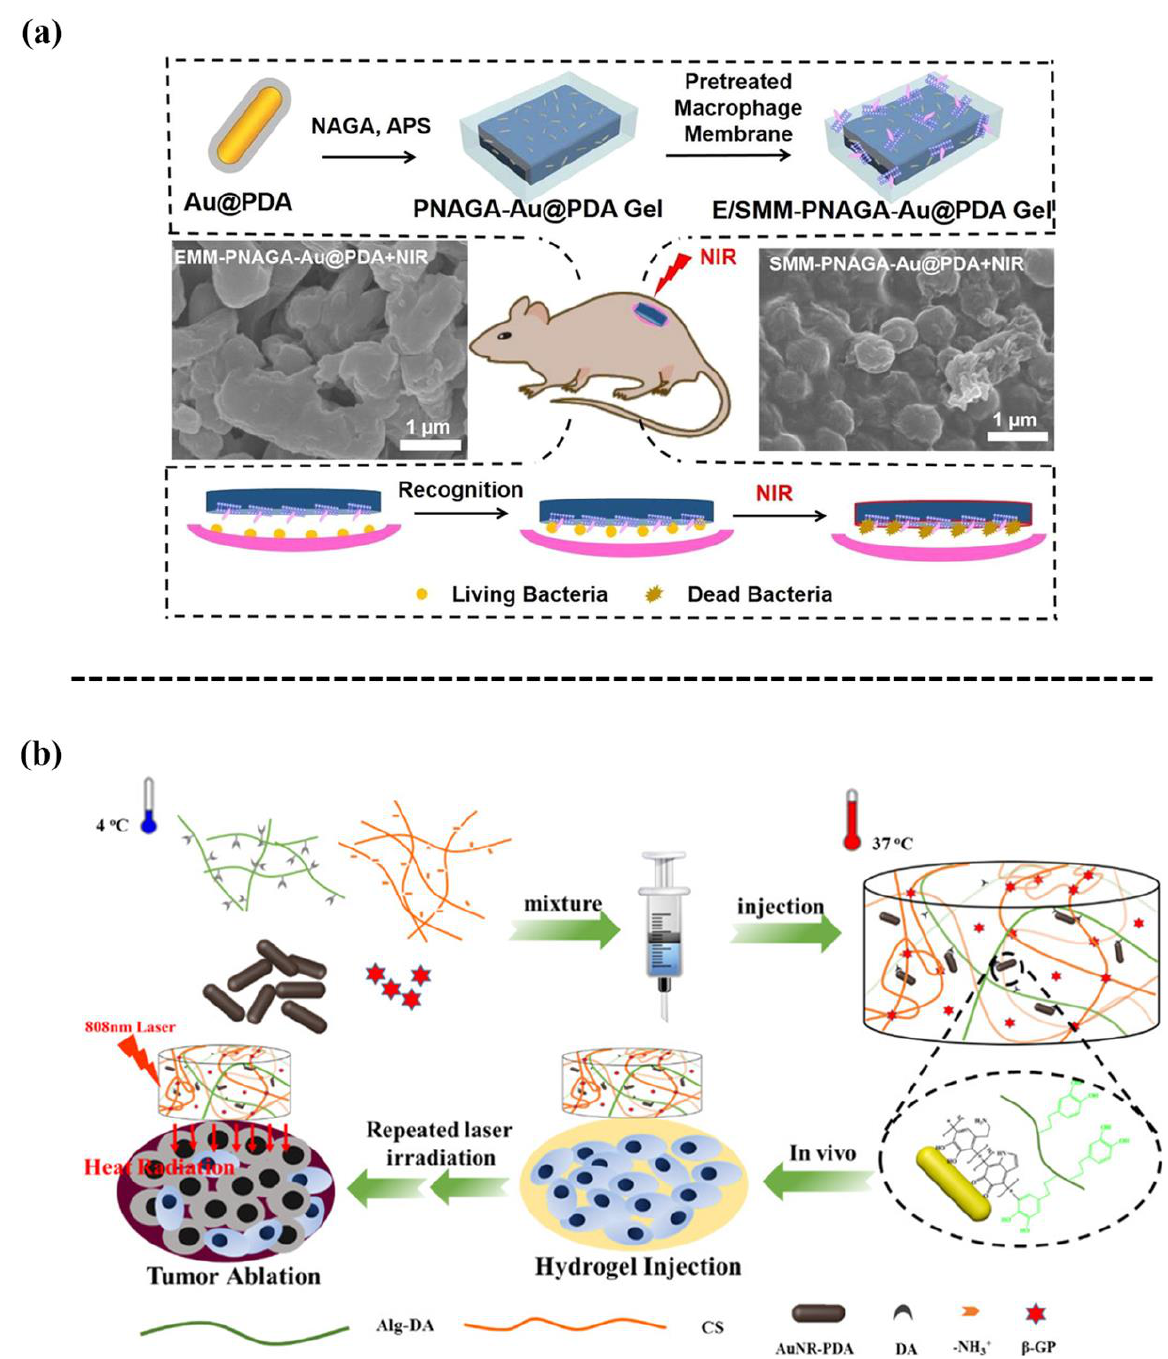
Figure 12. ( a ) Fabrication of nanocomposite antibacterial hydrogel with high strength and toughness by one-pot polymerization of N-acryloyl glycinamide (NAGA) mixed with polydopamine-coated gold nanorods (Au@PDA NRs) [79]. ( b ) Preparation of thermosensitive CGP/Alg-DA/AuNR hydrogels with photothermal activity for tumor therapy [80].